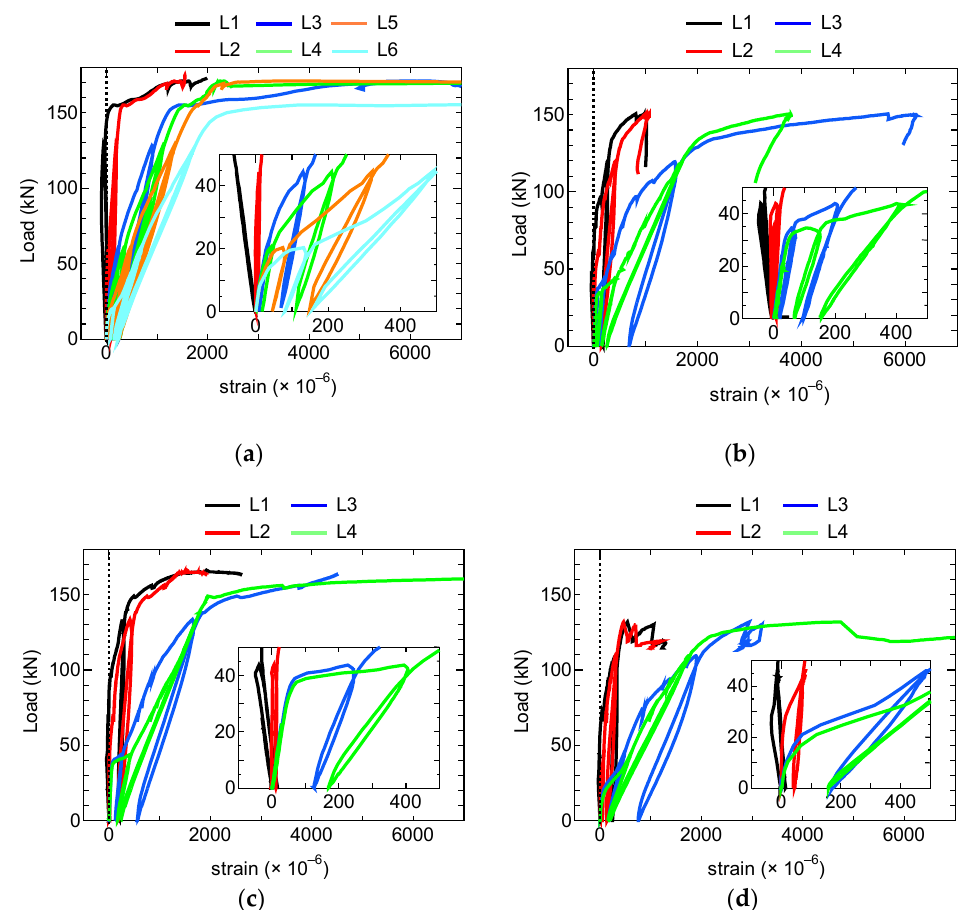
Figure 11. Relationship between applied load and strain of loop reinforcement in joint ( a ) Type A; ( b ) Type B; ( c ) Type C; ( d ) Type D (locations of L1 to L6 in Figure 5c).